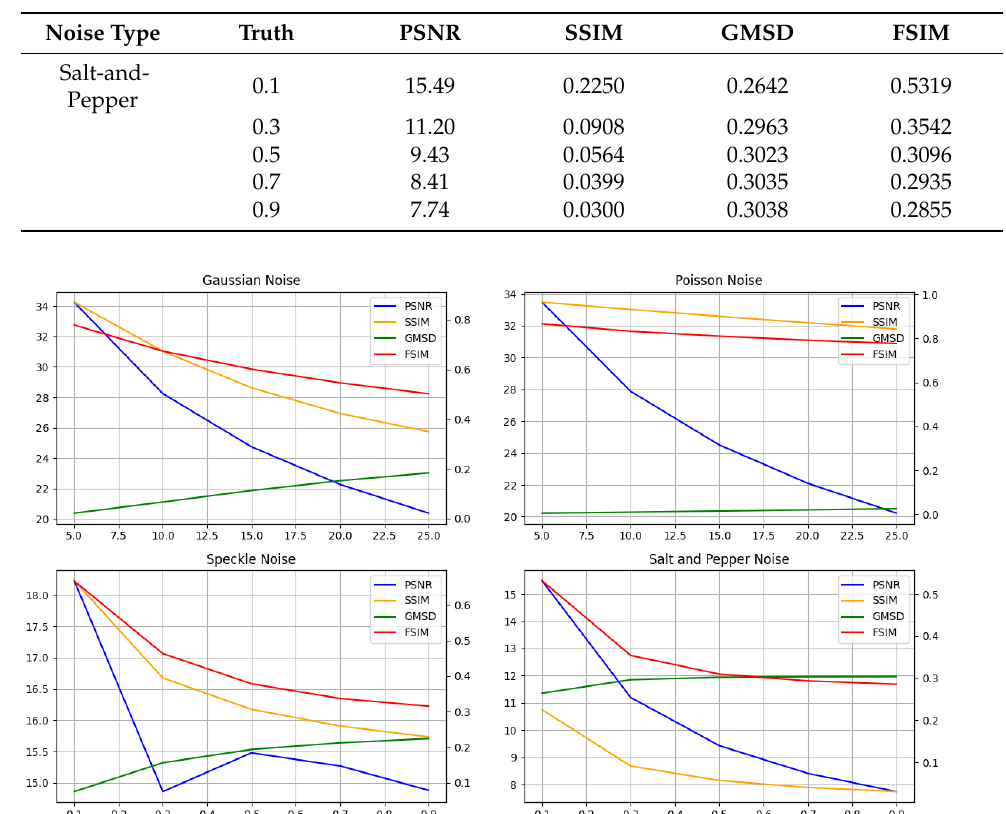
Figure 1. Comparison of IQA with respect to the noise